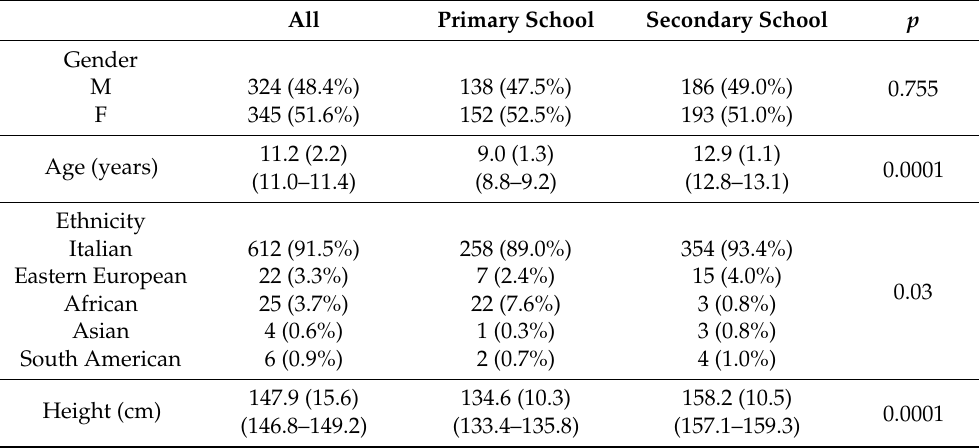
Table 1. Anthropometric characteristics of the 669 subjects, by school